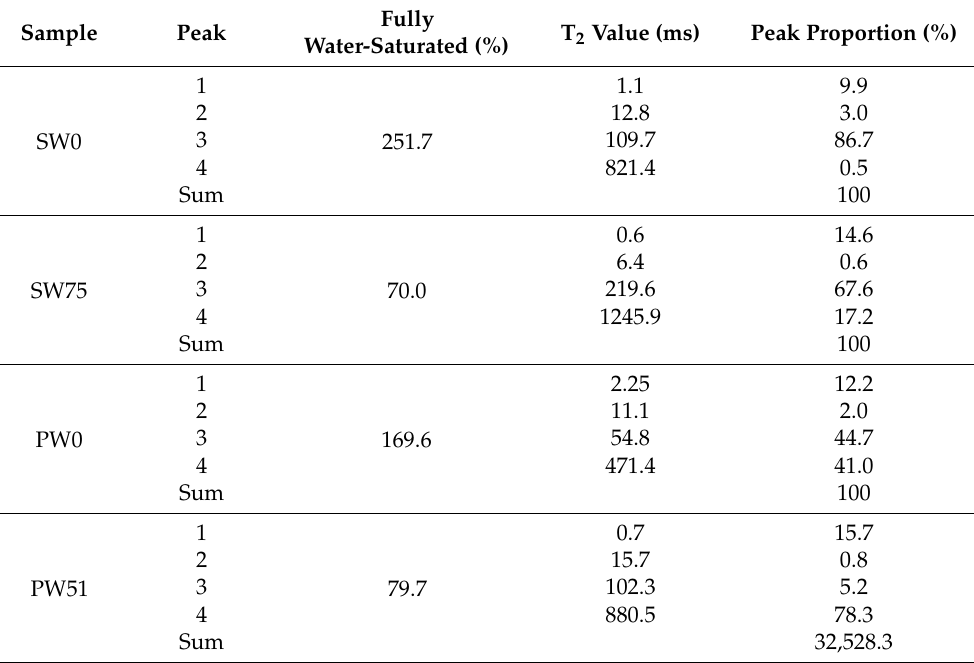
Table 3. The T 2 mean value, peak area, and proportion of furfurylated and untreated Chinese fir and poplar